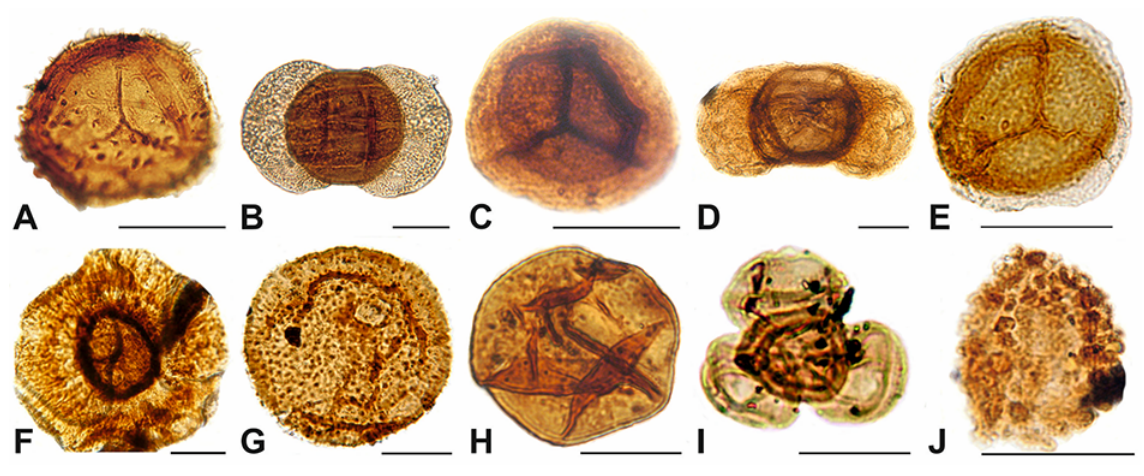
Figure 1 The index miospores of the Polish Triassic: ( A ) Lundbladispora obsoleta , Tumlin-Podgrodzie IG 1 borehole, depth 204.5 m, Lower Buntsandstein; ( B ) Protohaploxypinus pantii , Tumlin-Podgrodzie IG 1 borehole, depth 204.5 m, Lower Buntsandstein; ( C ) Densoisporites nejburgii , Podzamcze IG 1 borehole, depth 182.5 m, Middle Buntsandstein; ( D ) Voltziaceaesporites heteromorpha , Oblęgor IG 1 borehole, depth 90.9 m, Upper Buntsandstein (Röt); ( E ) Perotrilites minor , Opoczno PIG 2 borehole, depth 1,230.3 m, Lower Muschelkalk; ( F ) Heliosacuus domorphus , Opoczno PIG 2 borehole, 1,030.3 m, Lower Keuper; ( G ) Porcellispora longdonesis , Boża Wola IG 1 borehole, depth 1,316.0 m, Middle Keuper; ( H ) Aulisporites astigmosus , Mniszków IG borehole, depth 2,320.0 m, Middle Keuper; ( I ) Corollina / Classopllis meyeriana (tetrad), Włoszczowa IG 1 borehole, depth 1,770.0 m, Middle Keuper, ( J ) Riccisporites tuberculatus , Włoszczowa IG 1 borehole, depth 1,800.0 m, Upper Keuper. Scale bar: 30